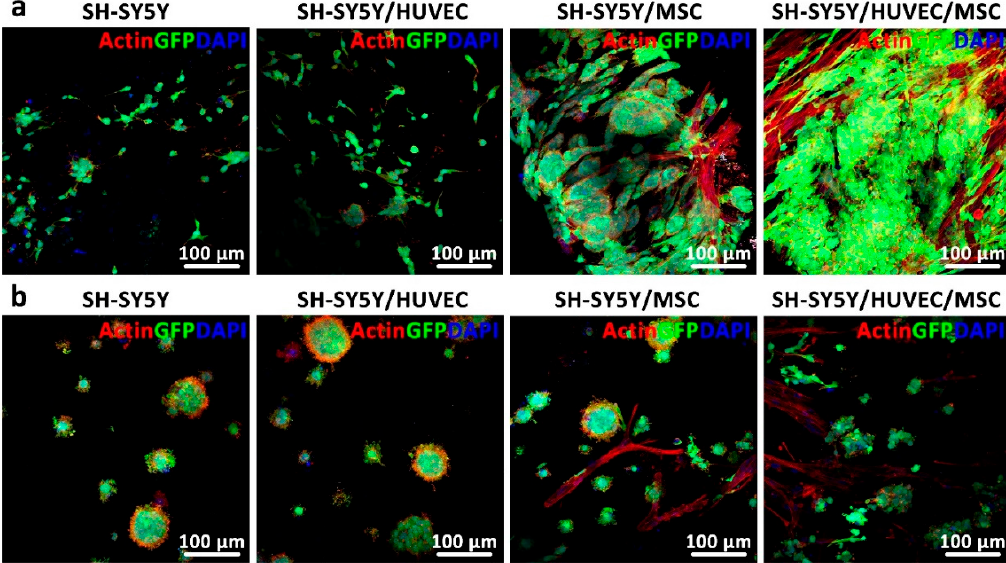
Figure 6. Two-photon images of SH-SY5Y distribution and interaction with HUVEC, MSC, and both HUVEC/MSC in non-bioprintable and bioprintable hydrogels. ( a , b ) Vascular tube formation was not observed in any of the studied bioinks in the presence of SH-SY5Y, contrarily to what was previously shown in the literature [21,22], whereas interaction of SH-SY5Y cells rosettes and MSC (elongated cells in red) was achieved.